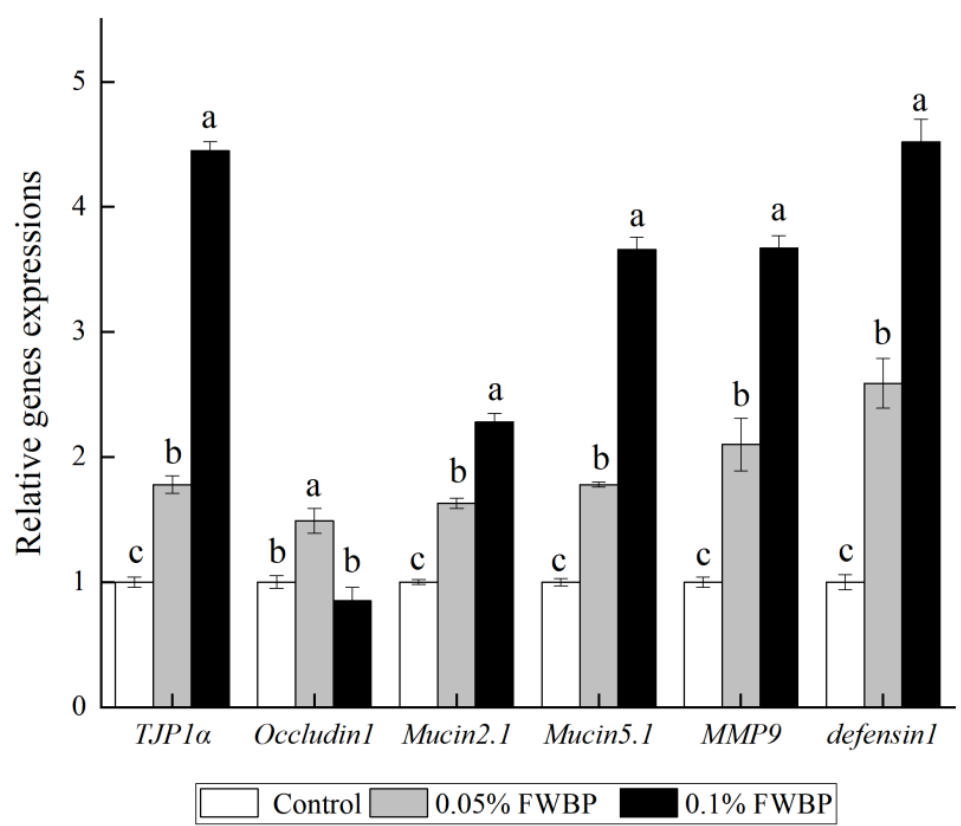
Figure 6. Gut mucosal barrier-related gene expression in zebrafish fed FWBP. FWBP: Fermented wheat bran polysaccharides. TJP α : Tight junction protein α ; MMP9: Matrix metalloproteinases 9. Different lowercase superscript letters denote statistically significant differences among different groups ( p < 0.05).